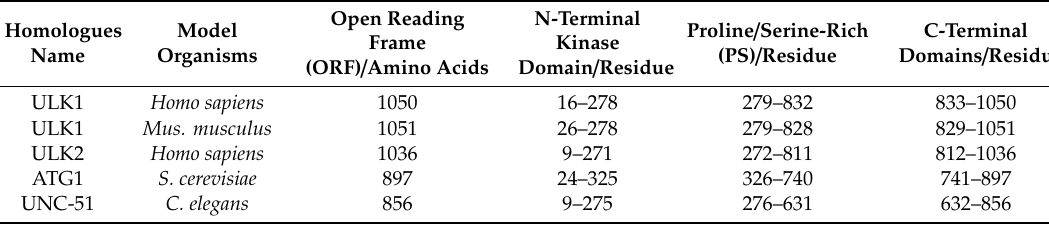
Table 1. Identity of ULK1 in Homo sapiens as compared with its homologues in other model organisms